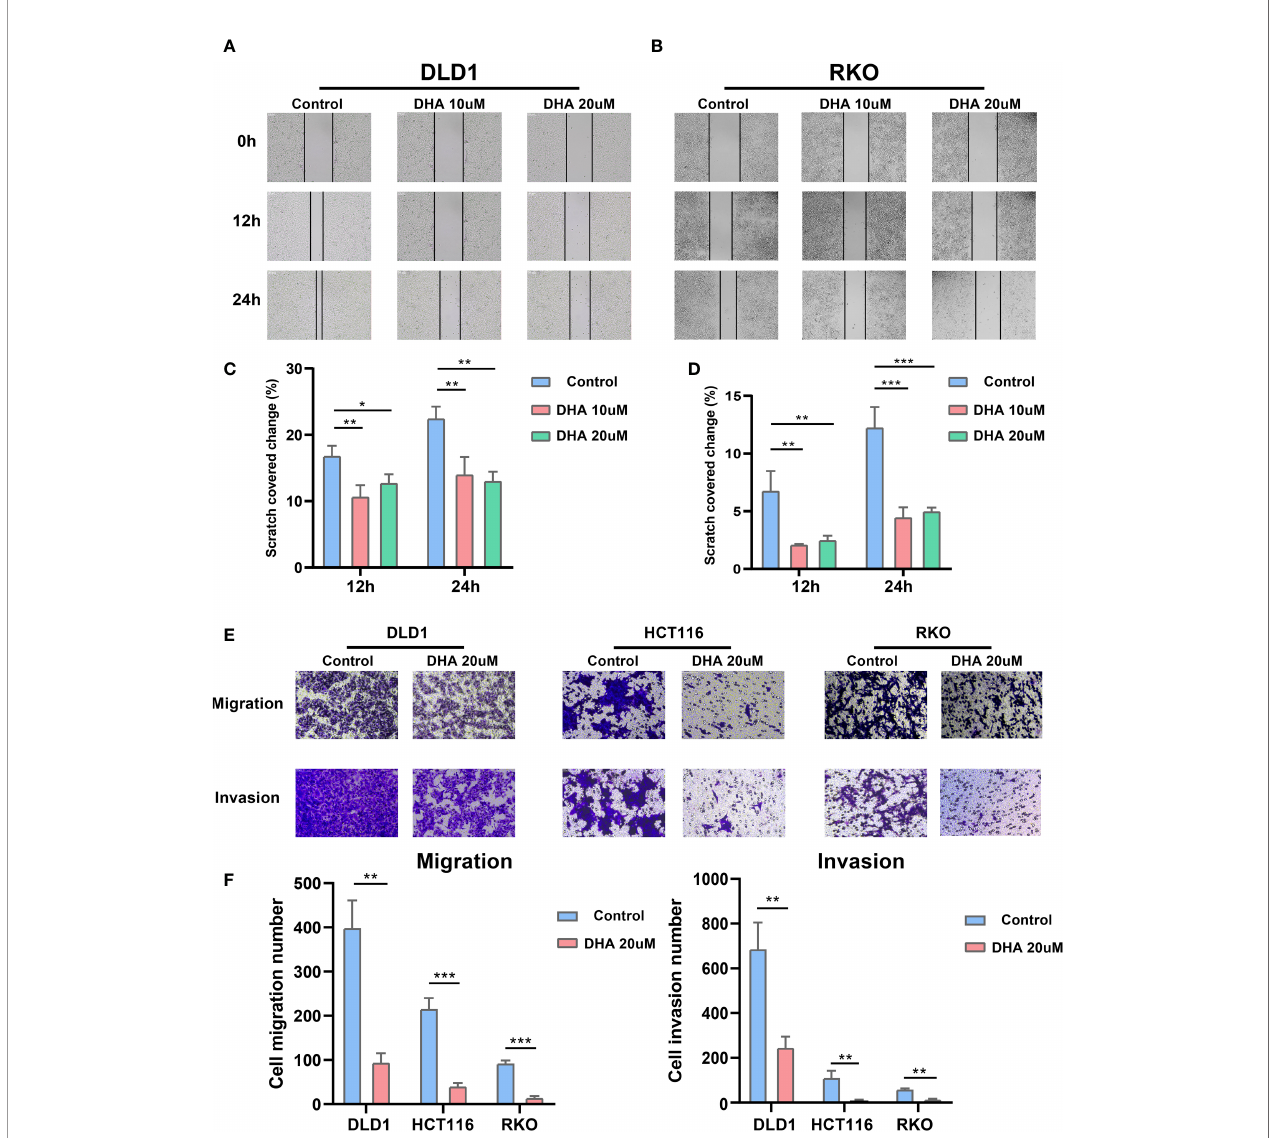
FIGURE 2 | DHA inhibited the invasive abilities of CRC cells. (A – D) The effects of DHA on cell mobilities were detected by the wound healing assay at different time points. (E, F) The effects of DHA on cell migration and invasion were assessed by the Transwell assay. Data are shown as means ± SD. *p < 0.05, **p < 0.01, ***p < 0.001. DHA, dihydroartemisinin; CRC, colorectal